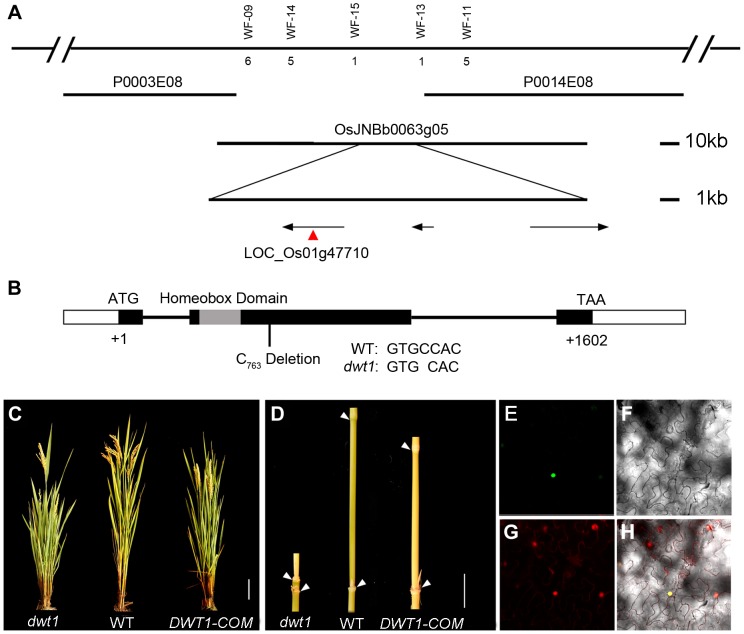
Molecular characterization of DWT1.A. Map-based cloning of the DWT1 gene. The chromosomal region containing DWT1 is diagrammed as the top line with molecular markers shown above the line. The number below the corresponding markers indicates the numbers of recombinants between the markers and DWT1. The BAC clones are shown as overlapping lines. B. Structure of the DWT1 gene. The mutant sequence has one nucleotide C763 deletion in the second exon. Black boxes indicate exons, white boxes indicate UTRs and lines indicate introns. The grey box shows the homeobox domain. C. The plant stature of dwt1, the wild type, and complemented transgenic plants (DWT1-COM). Bar = 10 cm. D. The morphology of the second internodes of dwt1, wild type, and complemented transgenic plants (DWT1-COM). Bar = 2 cm. E–H. Nuclear localization of DWT1 protein. YFP fluorescence image (E), light view (F), PI stained image (G) and overlay of the three images (H) of Nicotiana benthamiana leaf epidermal cell transformed with the 35S:DWT1-YFP construct.